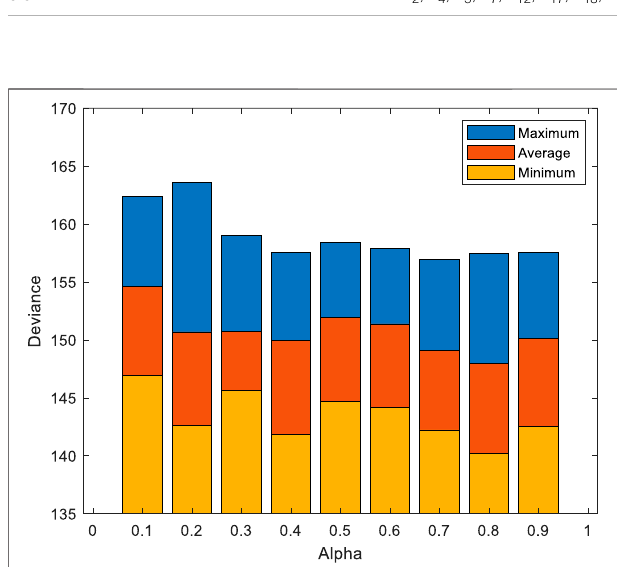
FIGURE 1 | Variation curves of different alpha values. The alpha values range from 0.1 to 0.9, and there are different degrees of differences between themaximum, minimum,andaveragevalues.Whenalpha=0.8,theminimum and average value of deviance are the minimum values, which are 148.01 and 140.22,